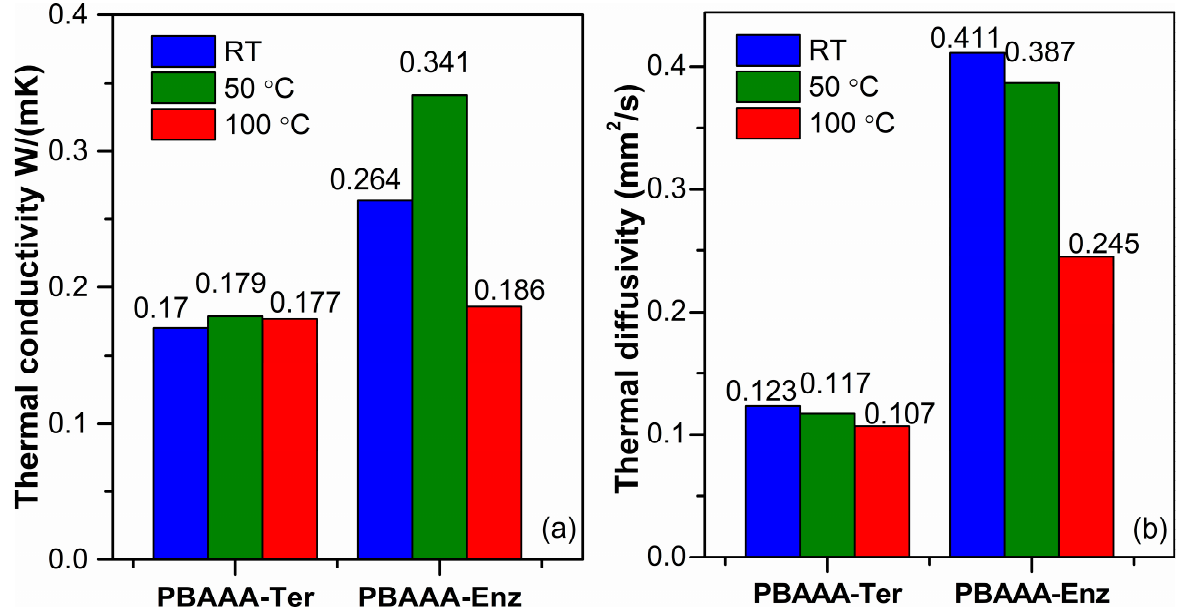
Figure 9. ( a ) Thermal conductivity results for PBAAA_Enz and PBAAA_Ter at RT (blue column), 50 °C (green column), and 100 °C (red column). ( b ) Thermal diffusivity for PBAAA_Enz and PBAAA_Ter at RT (blue column), 50 °C (green column), and 100 °C (red column). The values shown are the means of three independent measurements for each sample at each investigated temperature.